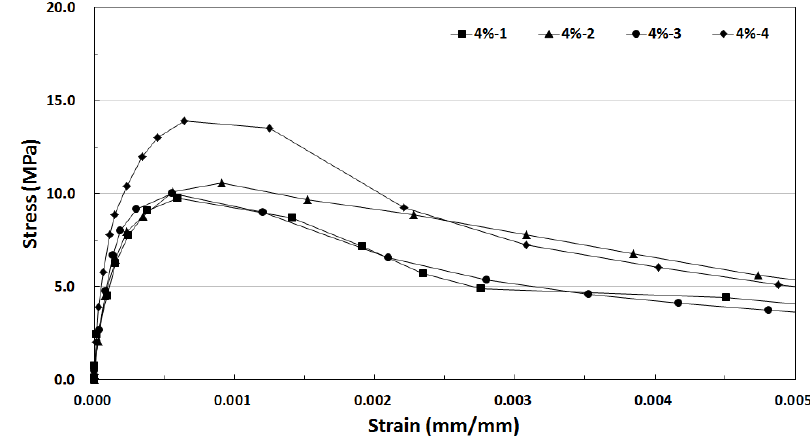
Figure 11. Tensile stress-strain curve of SIFRCCs with 4% fiber volume fraction.